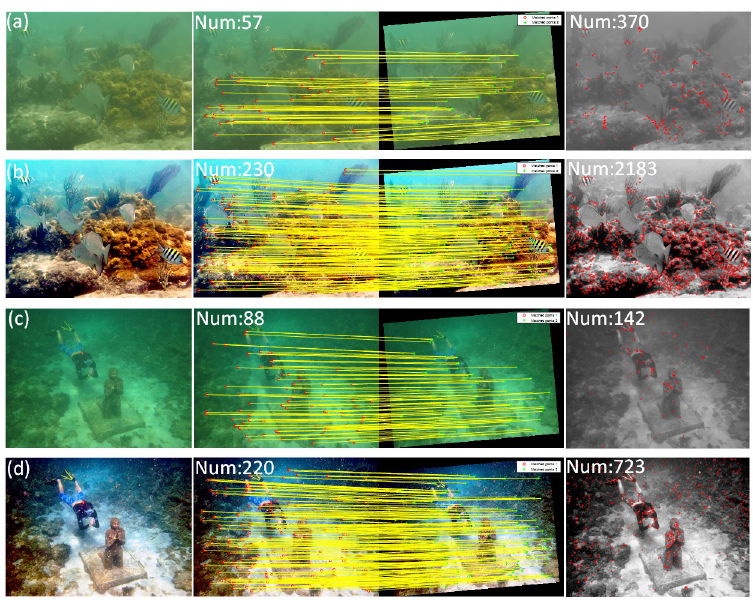
Fig 14. SURF matching and corner detection. (a) Degraded image 1, SURF and corner; (b) Corrected image 1, SURF and corner; (c) Degraded image 2, SURF and corner; (d) Corrected image 2, SURF and corner.